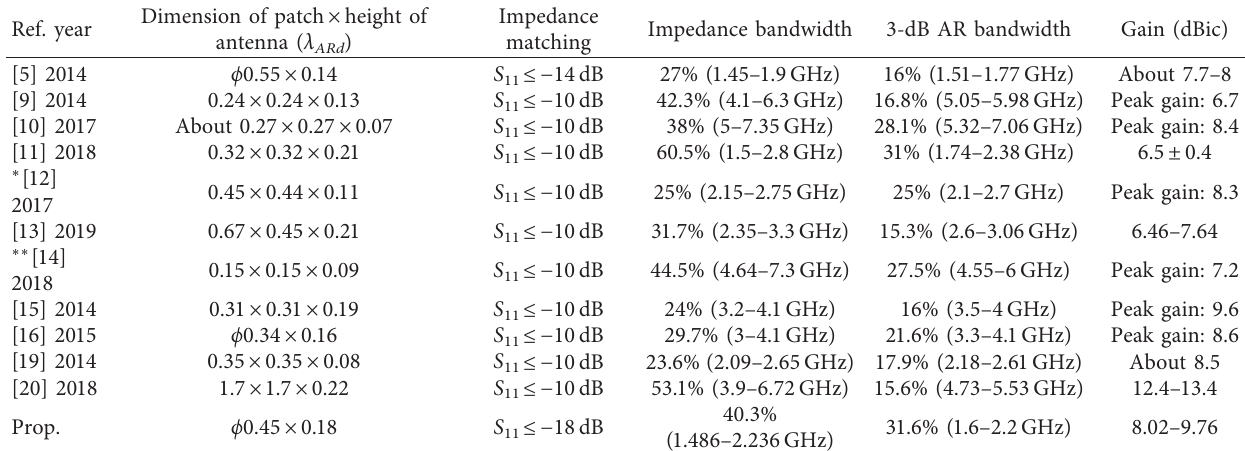
λ ARd is the free-space wavelength at the starting frequency of the 3-dB AR bandwidth. ∗ λ ARd is the free-space wavelength at 2.15GHz. ∗∗ λ ARd is the free-space wavelength at Figure 18. The 3-dB beamwidth is more than 45 ° for both planes.